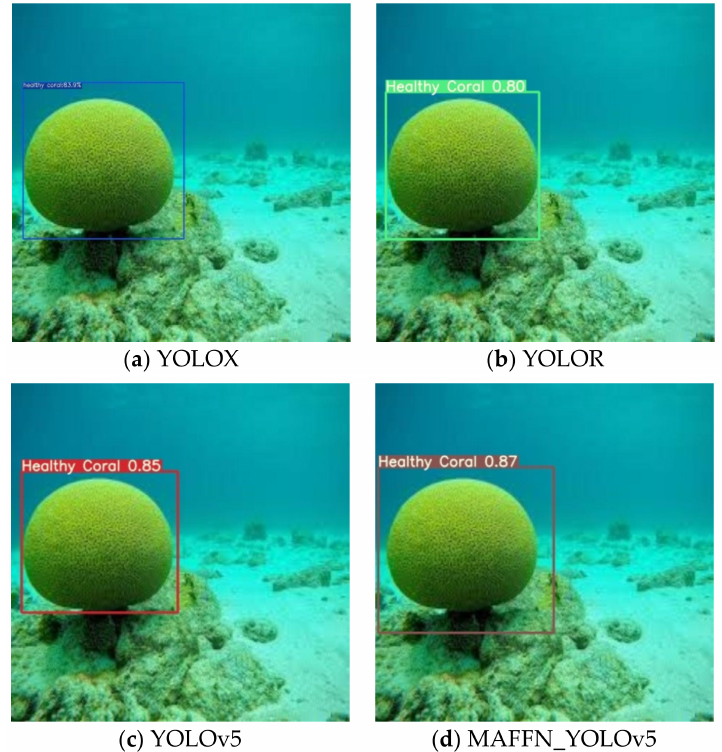
Figure 23. Healthy coral-reef